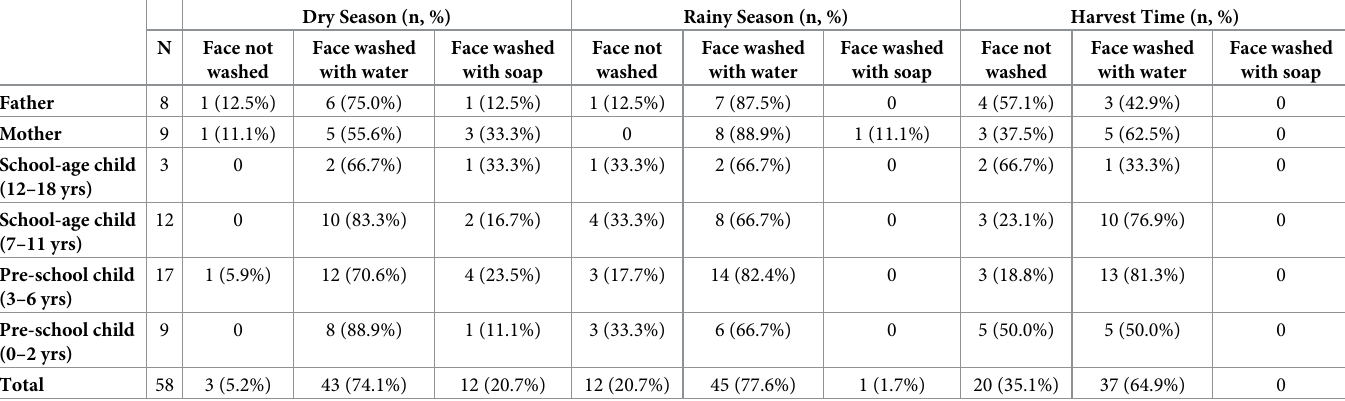
Table 4. Seasonal variation in proportion of household members washing faces over the course of the Day 1 observation perio. Dry Season (n, %) Rainy Season (n, %) Harvest Time (n, %) Face washed Face washed with water with